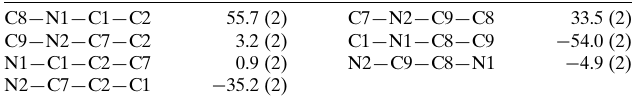
Table 1 Selected torsion angles ( (cid:3) ).